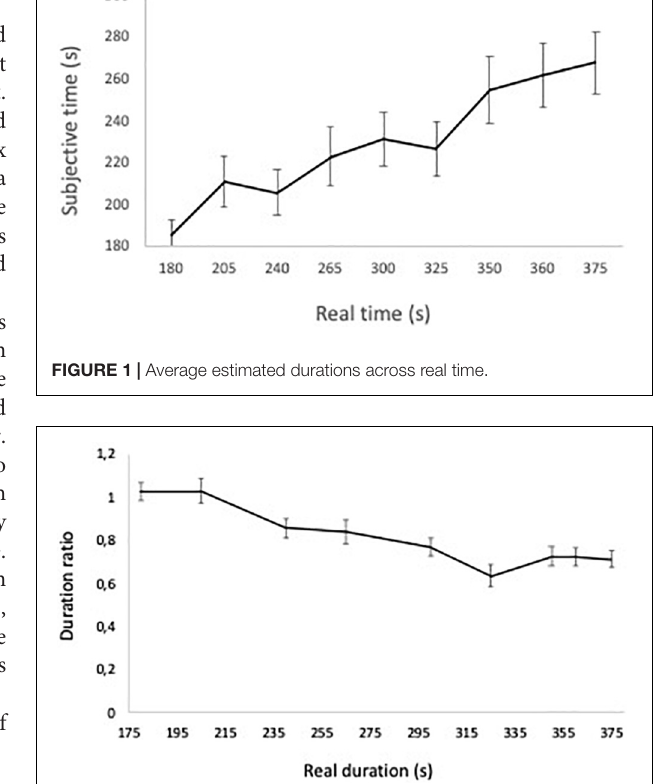
FIGURE 2 | Ratio of estimated duration to real duration, across real